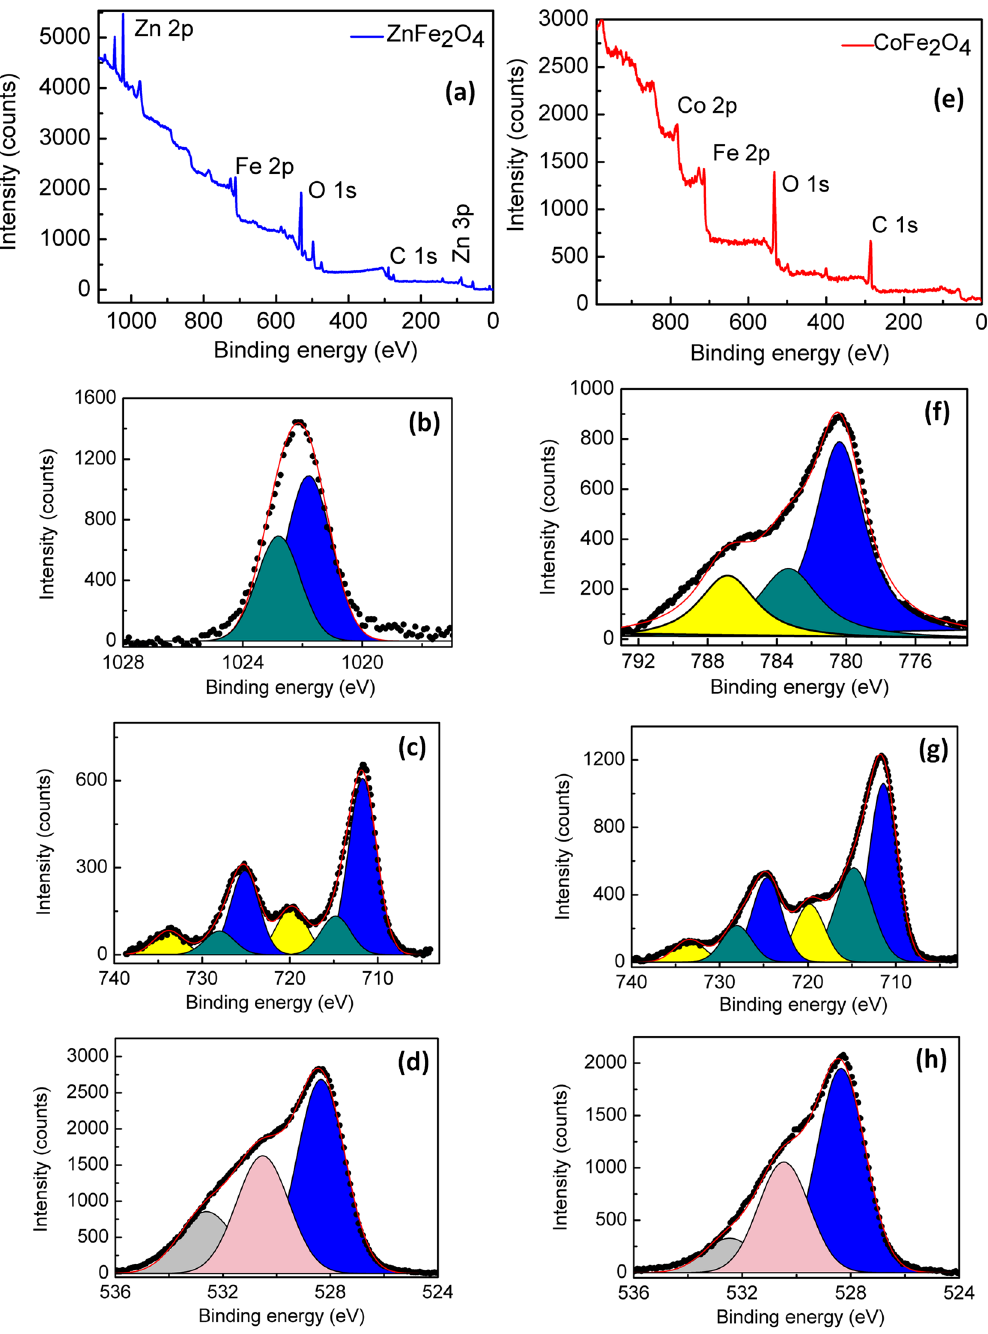
Fig. 3 Survey XPS spectra for the a ZnFe 2 O 4 and e CoFe 2 O 4 NPs calcined at 800 °C. HRXPS for Zn ferrite nanoparticles calcined at 800 °C for: b Zn 2 p ; c Fe 2 p ; d O1 s . HRXPS for Co ferrite nanoparticles calcined at 800°C for: f Co 2 p ; g Fe 2 p ; h O1